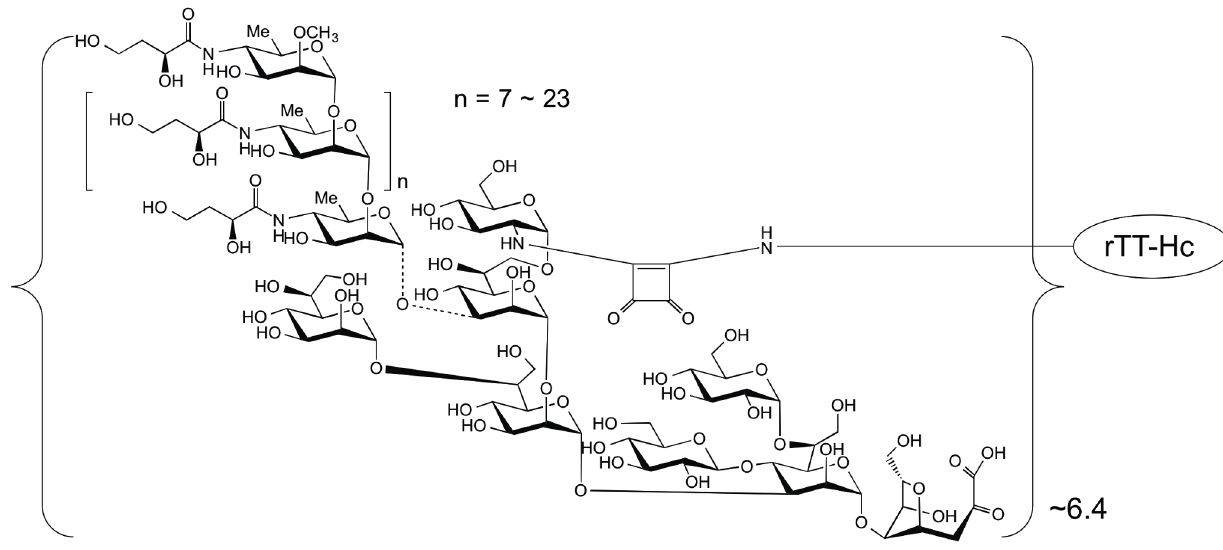
Figure 1. Structure of Ogawa OSP:TThc conjugate. 6.4 moles OSP per mole conjugate. TThc=recombinant tetanus toxoid heavy chain fragment.